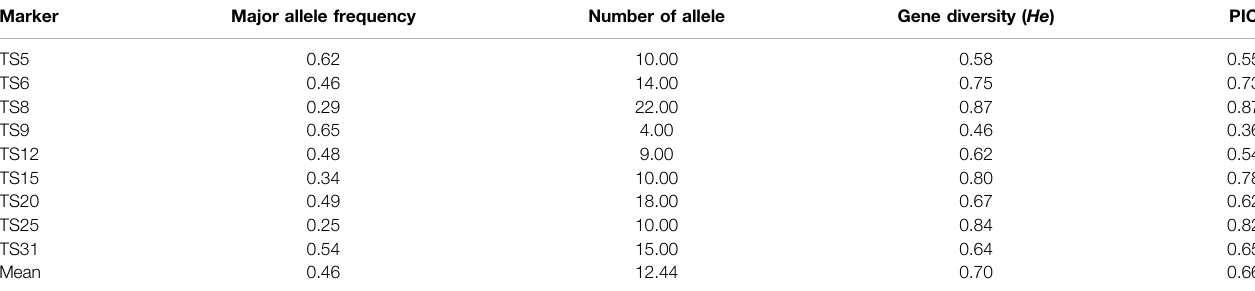
TABLE 2 | Major allele frequency, gene diversity, number of alleles and polymorphic information content (PIC) of the nine microsatellite markers used in this study. Marker